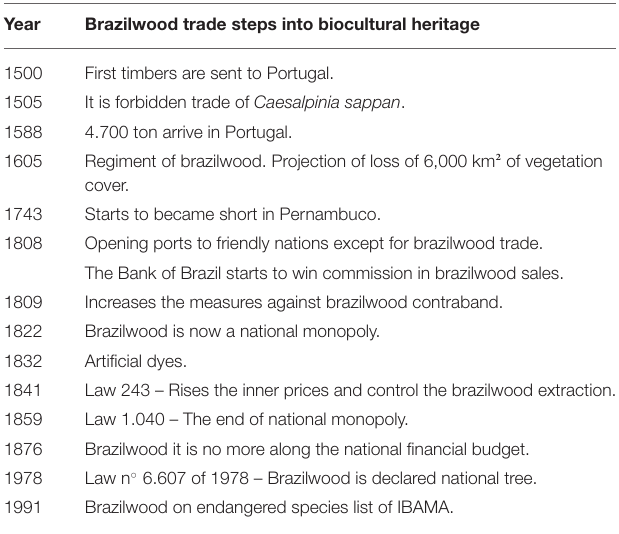
TABLE 1 | Historical marks showing how brazilwood became a Brazilian biocultural